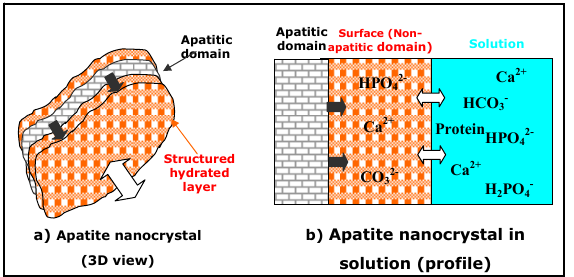
Figure 1. Schematic representation of the surface hydrated layer model for poorly crystalline apatite nanocrystals (Reprinted from Nanocrystalline apatite based biomaterials: synthesis, processing and characterization ; Copyright (2009), Eichert D., Drouet C., Sfihi H., Rey C. and Combes C. [43] with permission from Nova Science Publishers Inc.).